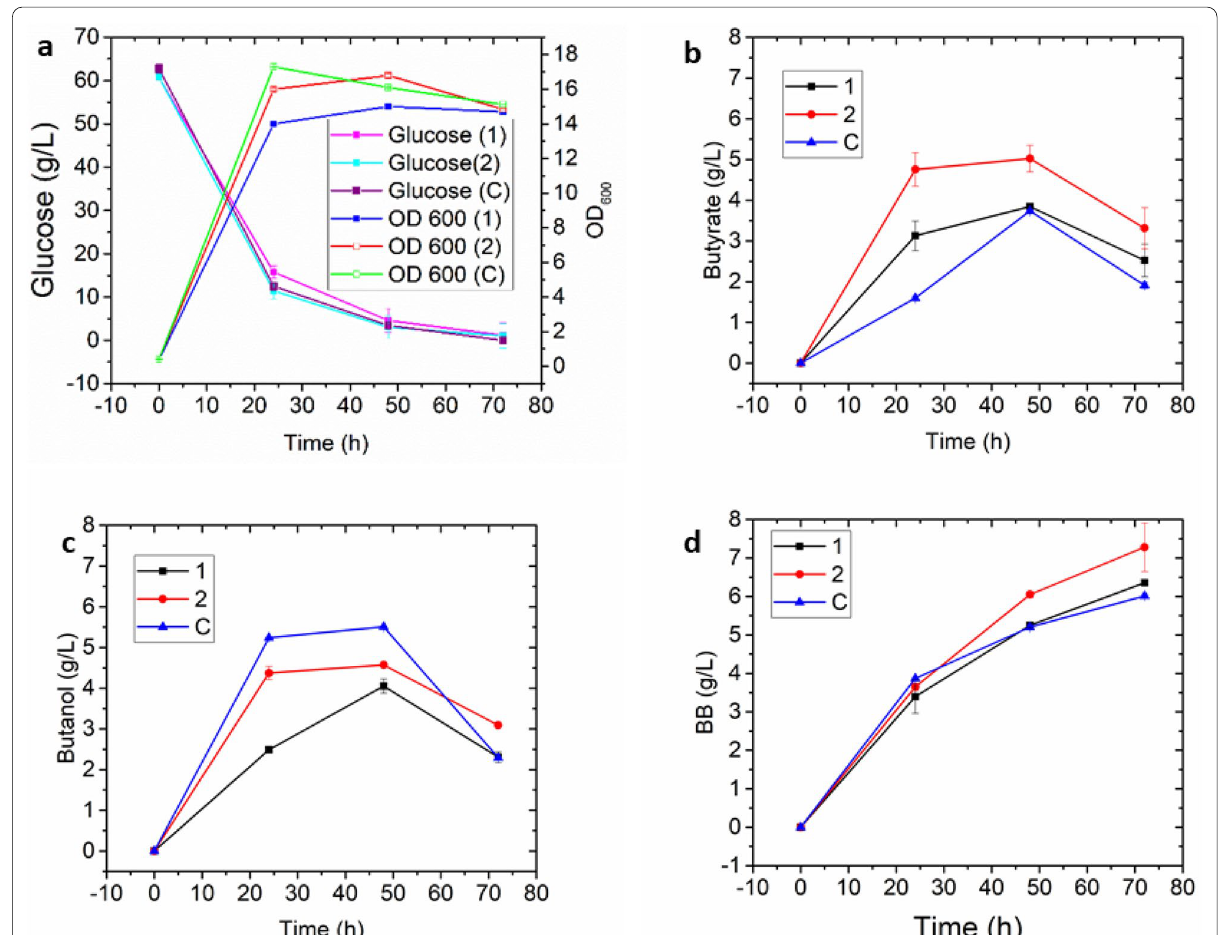
Fig. 6 Batch fermentation profiles of the microbial consortium for butyl butyrate production with different aeration speed control strategies. The consortium strains were inoculated at a ratio of 1:8 (butyrate strain: butanol strain) and cultured at 200 rpm, pH 5.8. C: control, aerated with 0.5 vvm during the whole fermentation process. 1: aerated with 0.5 vvm in the first 24 h, then shifted to 0.1 vvm. 2: aerated with 0.5 vvm in the first 36 h, then shifted to 0.1 vvm. The data represent the means SD from three biological ±